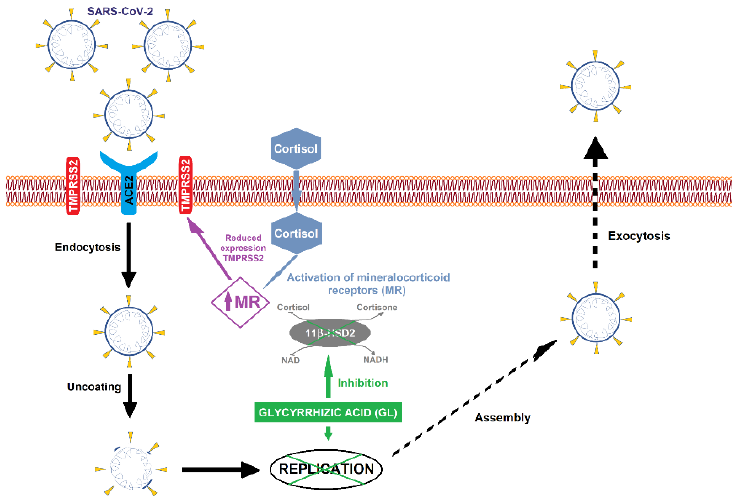
Figure 3. Schematic representation of glycyrrhizic acid effect on SARS-CoV-2 virus replication. The penetration of the SARS-CoV-2 virus into the cells, where it finds the ideal conditions for its replication, is mediated by ACE2 receptor with TMPRSS2 co-factor. Since ACE2 expression is regulated by MR (mineralocorticoid receptors), GL (green box) inside the cell inhibits 11 β -HSD2 enzyme, allowing cortisol to activate MR. Then, the activation of MR leads to reduction of TMPRSS2 expression, causing an ACE2 downregulation. The 11 β -HSD2 inhibition restricts the virus access to the cell, and consequently, the virus replication is